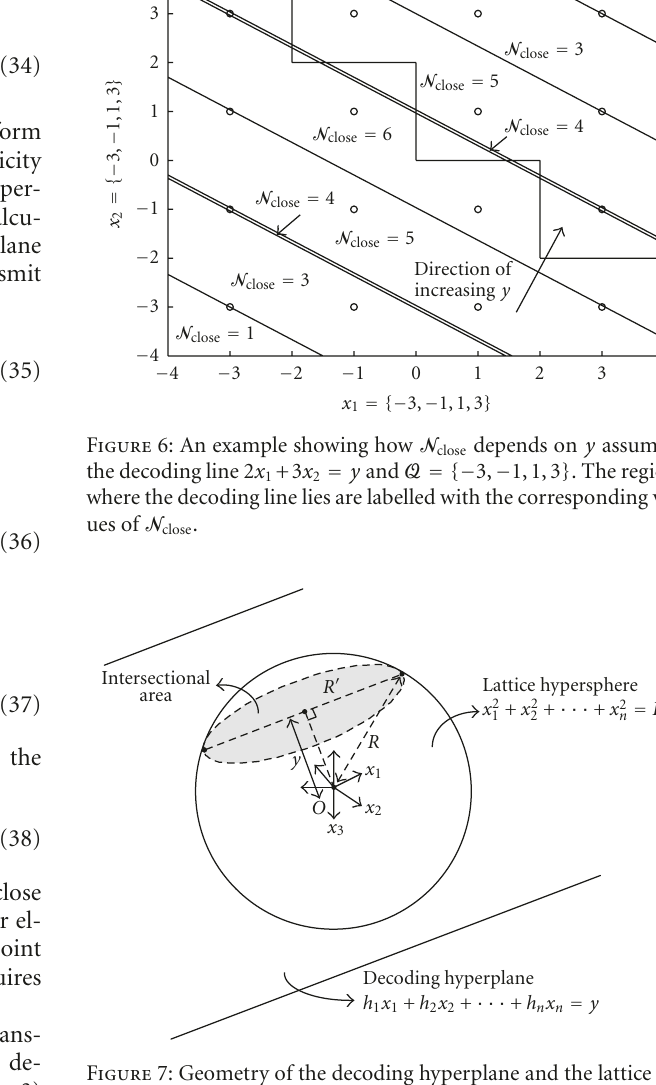
Figure 7: Geometry of the decoding hyperplane and the lattice hy-